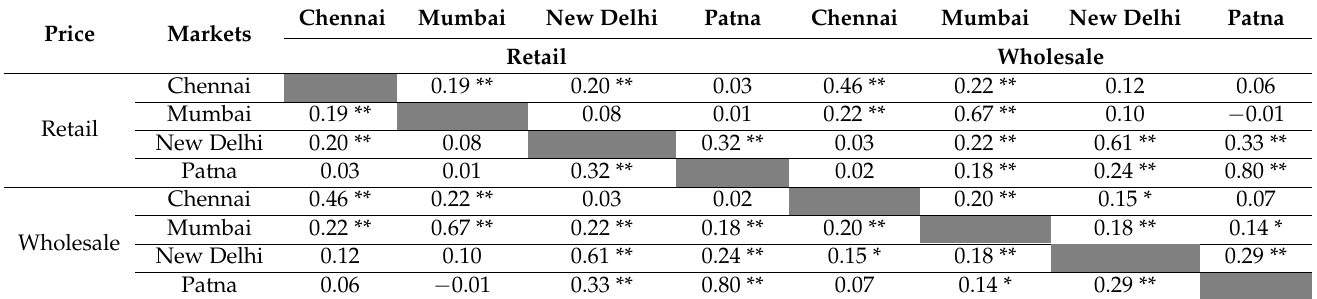
Table 7. Estimates of the correlation for wheat markets.